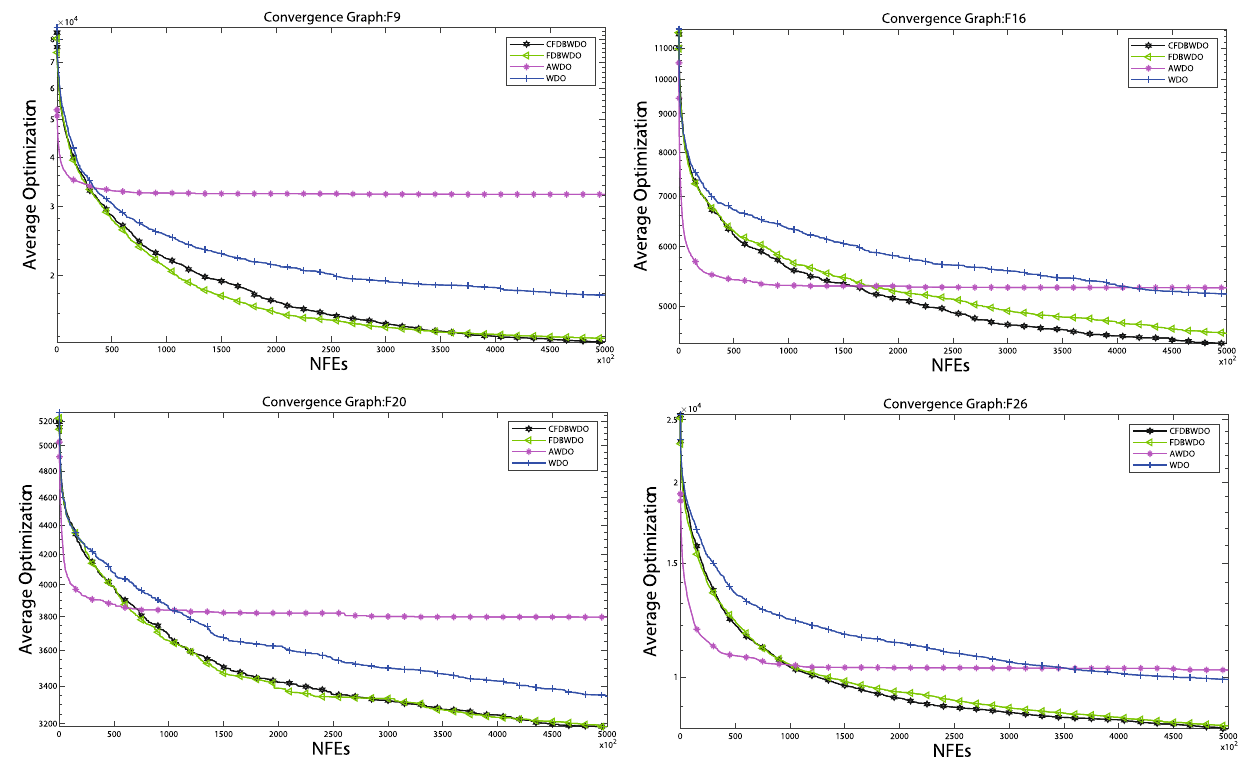
Fig. 8 Convergence graphs of four WDO variants on F9, F16, F20 and F26 with 50